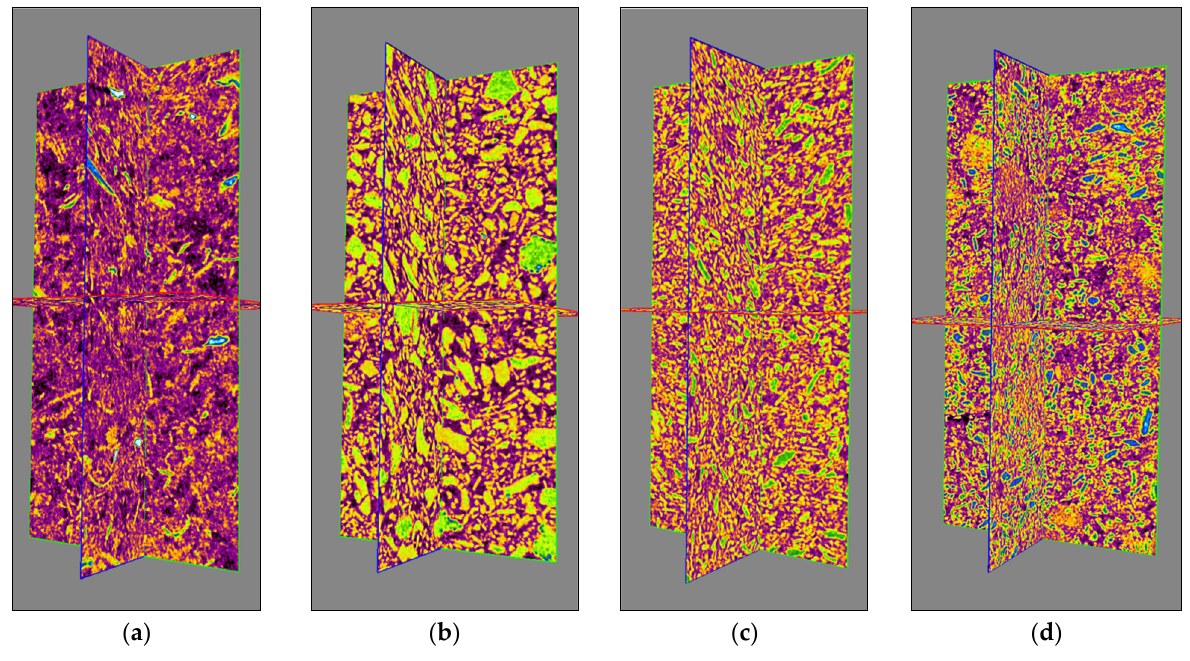
Figure 3. Reconstructed 2D images of X-ray diffraction analysis of the mushroom powders: ( a ) FD; ( b ) HAD; ( с ) MWD; ( d ) SD.